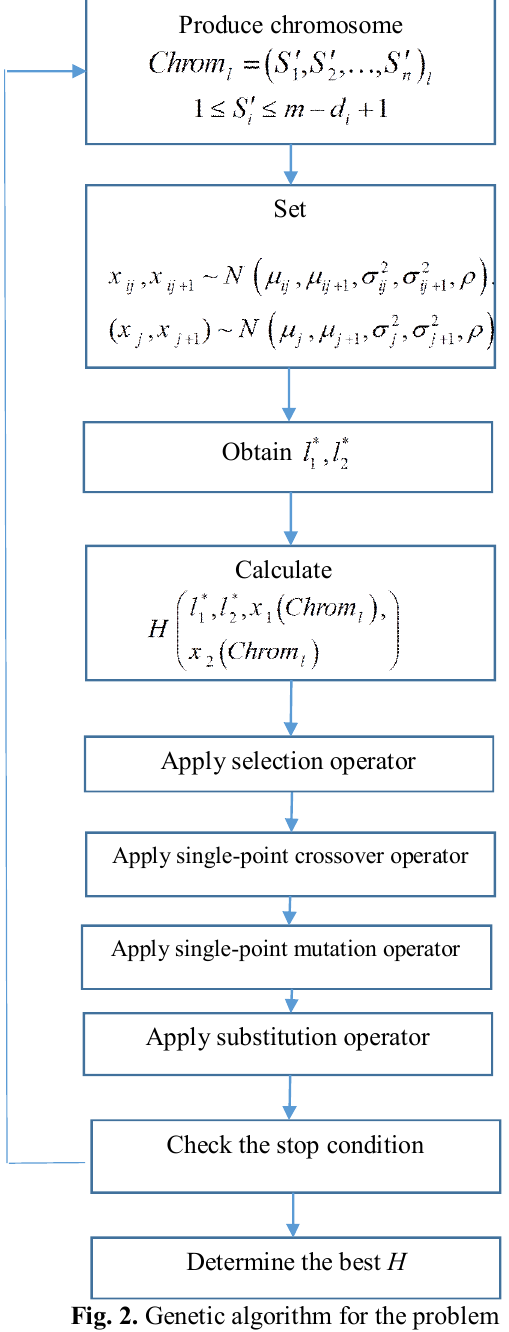
Fig. 2. Genetic algorithm for the